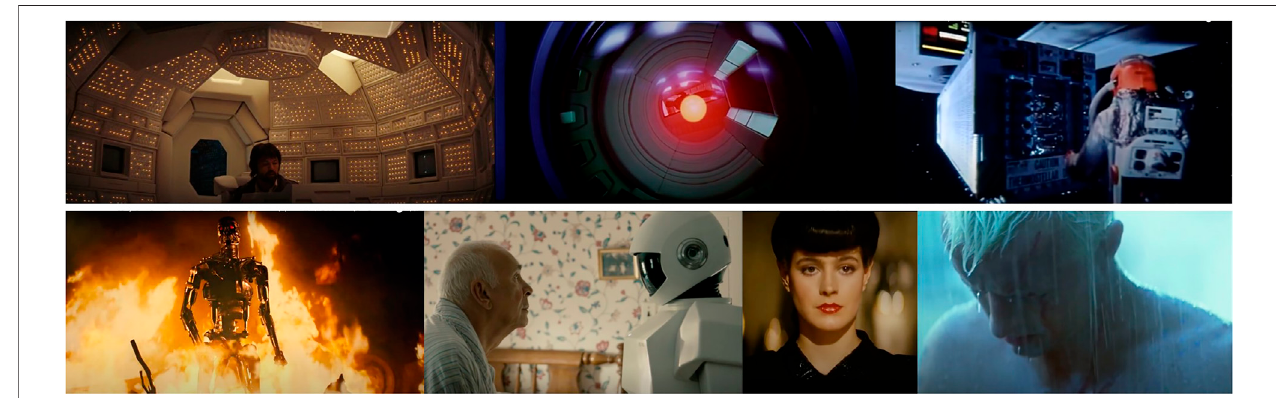
FIGURE1 | Examples ofmovie presentations of AIembodiments. From upper left tolower right: Dallas (Tom Skerrit) talking to mother , the ship ’ s AI(all around him inthebackground) viaaterminalin Alien (Scott, 1979);Thefamousred eyeofH.A.L.9,000,theAIin 2001:ASpaceOdessey (Kubrick,1968),whichlater followsits own agenda;PhilosophicaldebatebetweenDoolittle(BrianNarelle)andreeled-outbomb20,astarkillingdevice,whynottodetonateonpotentiallyfalseevidencein DarkStar (Carpenter,1974);ThethreateningT800steppingoutofthe fi retohuntdownitshumanpreyinthedystopian fi ction TheTerminator (Cameron,1984);Franktalking to his domestic robot who later becomes his partner in crime in Robot & Frank (Schreier, 2012); Two replicants, bio-engineered synthethic humans, in Blade Runner (Scott, 1982), Rachel (Sean Young), who does not know about her real form of existence and operating/lifetime expecation, and Roy Batty (Ruttger Hauer), philosphing about the essence of life before he dies at the end of his operating/lifetime expecation. Screenshots made by the authors.